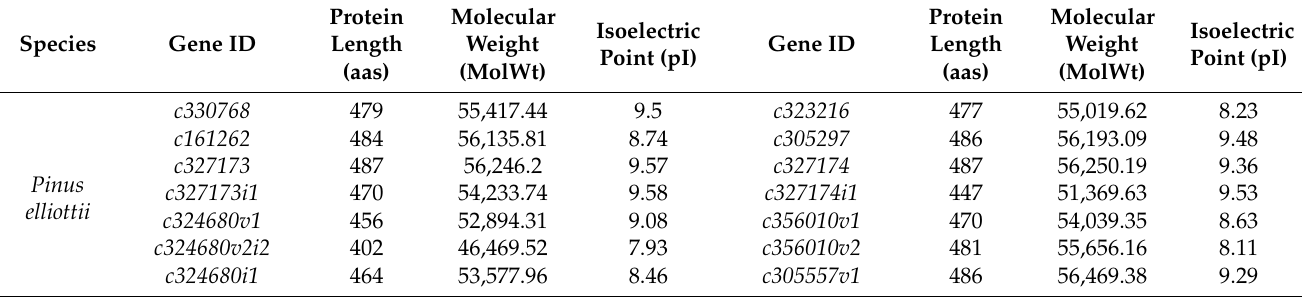
Table 1. Basic information on the CYP720B subfamily of slash pine ( Pinus elliottii ) and loblolly pine ( Pinus taeda